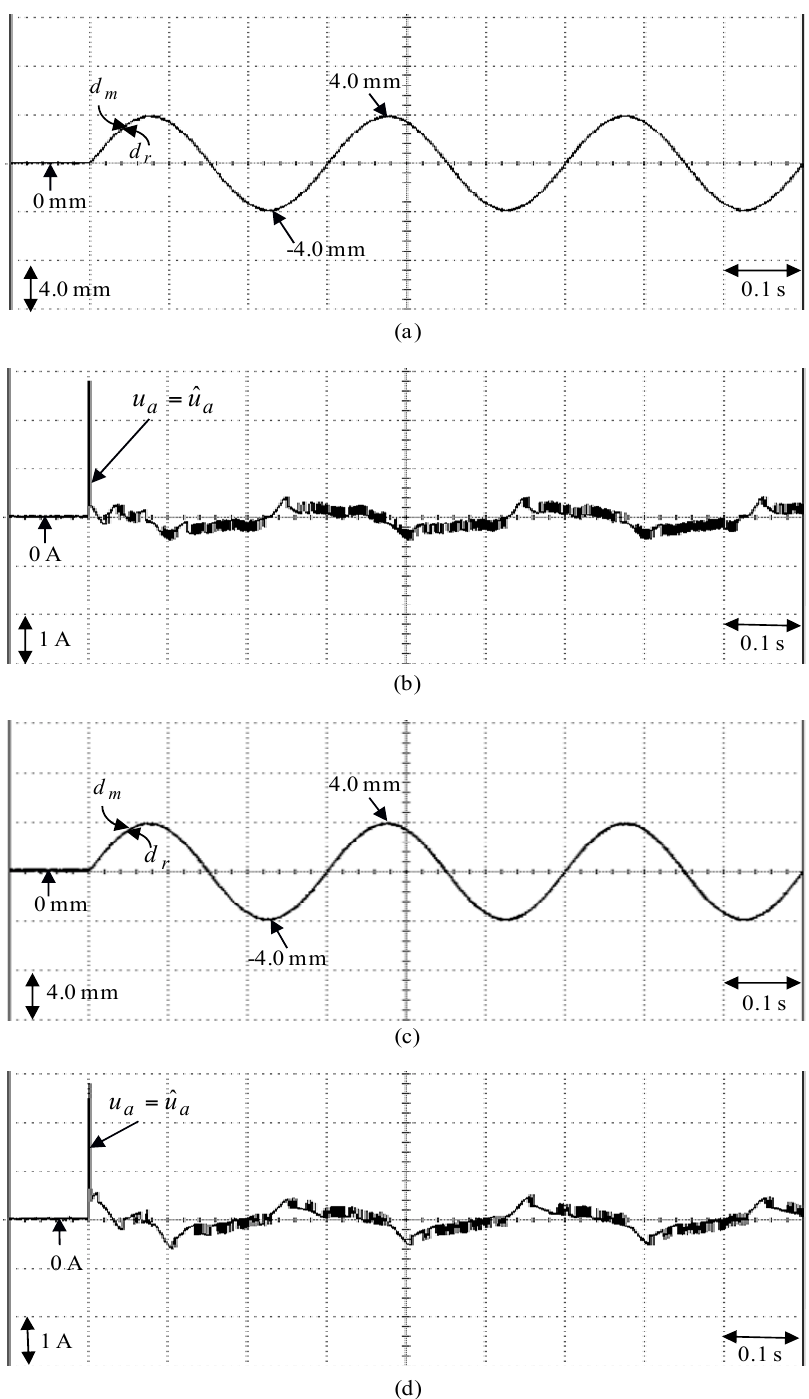
Figure 16. Experimental results of the proposed AAENNB control system due to periodic sinusoidal command from − 4.0 mm to 4.0 mm: ( a ) position reaction of the mover in Case 3, ( b ) reaction of control effort in Case 3, ( c ) position reaction of the mover in Case 4, ( d ) reaction of control effort in Case 4.